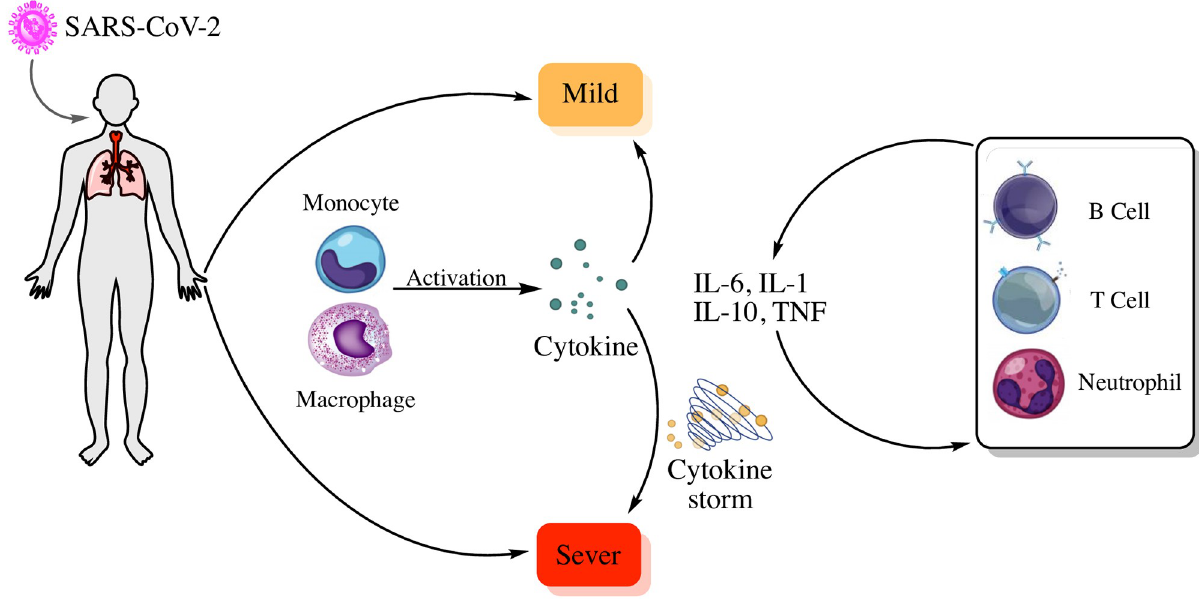
Fig 4. Schematic illustration of SARS-CoV-2 infection and the role of HIF − 1 α on SARS-CoV-2 pathogenesis.